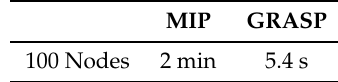
Table 7. Comparison of the execution times for the MIP model and the GRASP meta-heuristic for N = 100 nodes and one critical node